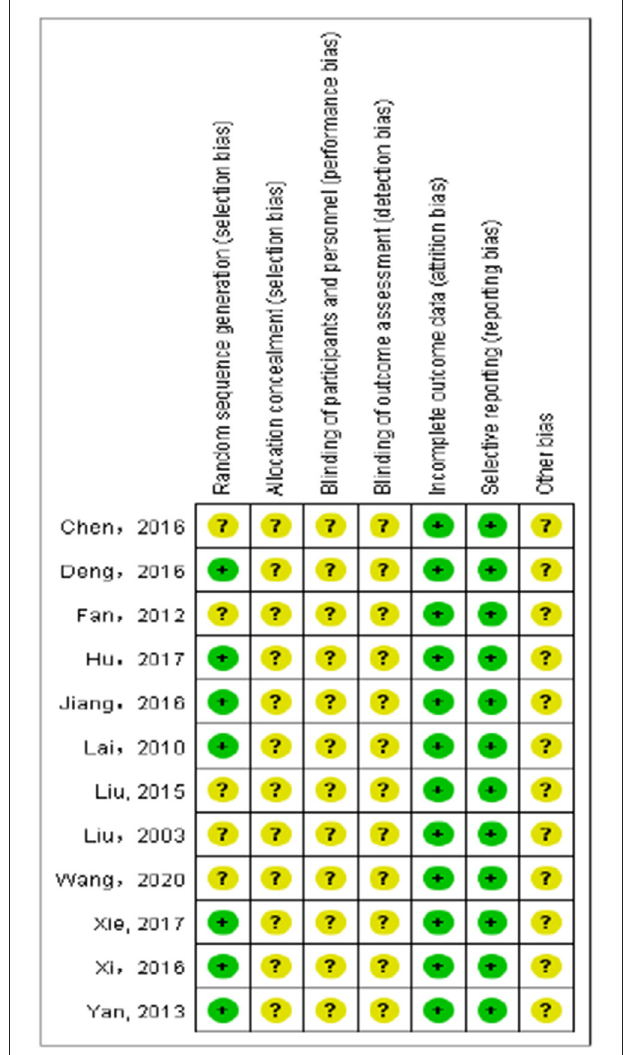
FIGURE 3 | Risk of bias